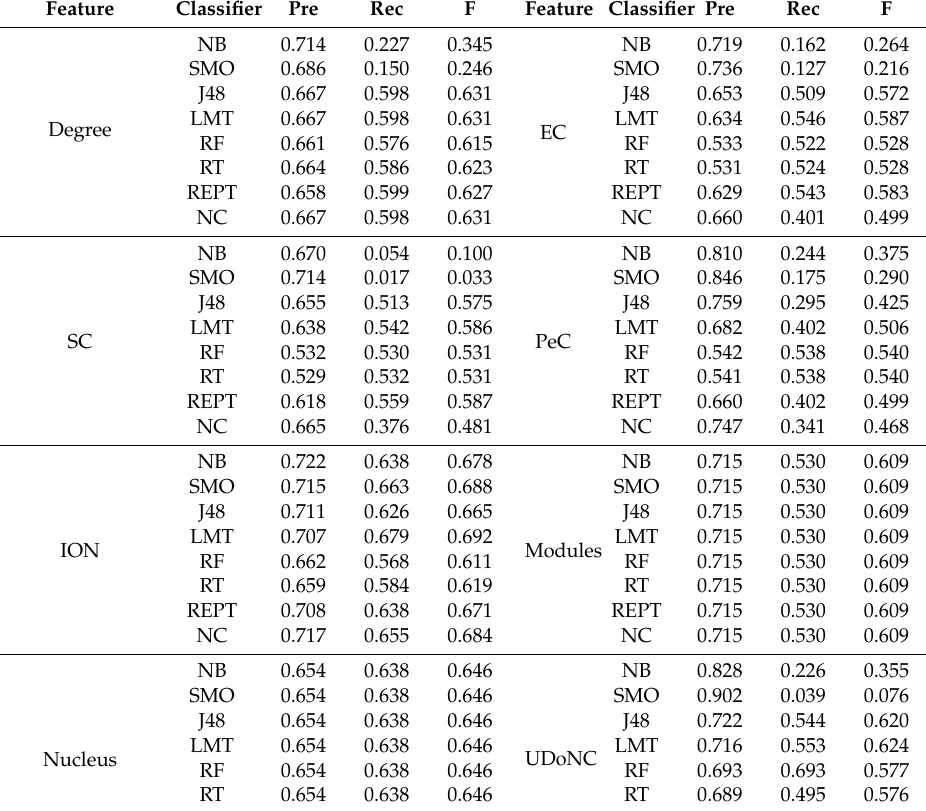
Table 4. Comparing the performance of diverse